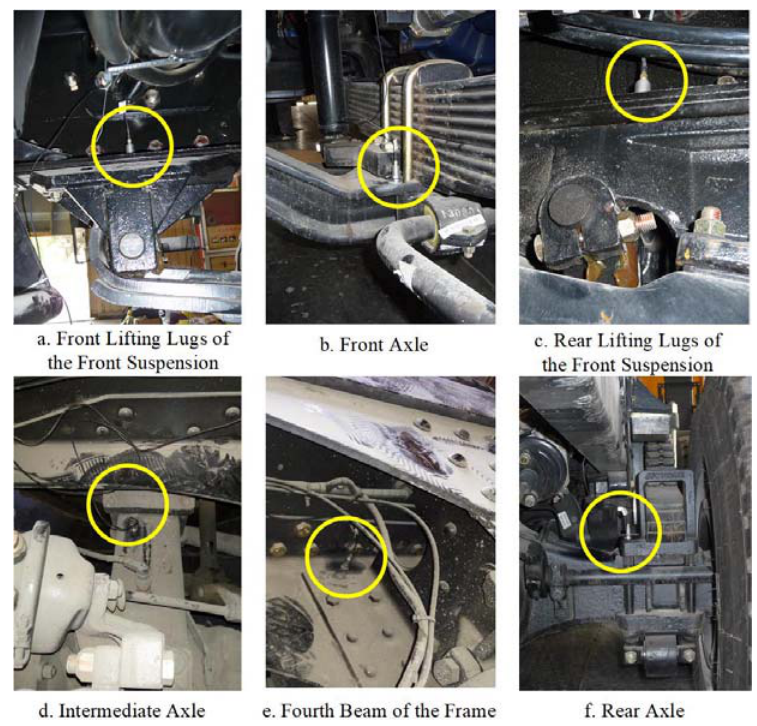
Figure 12. Position of accelerometers.